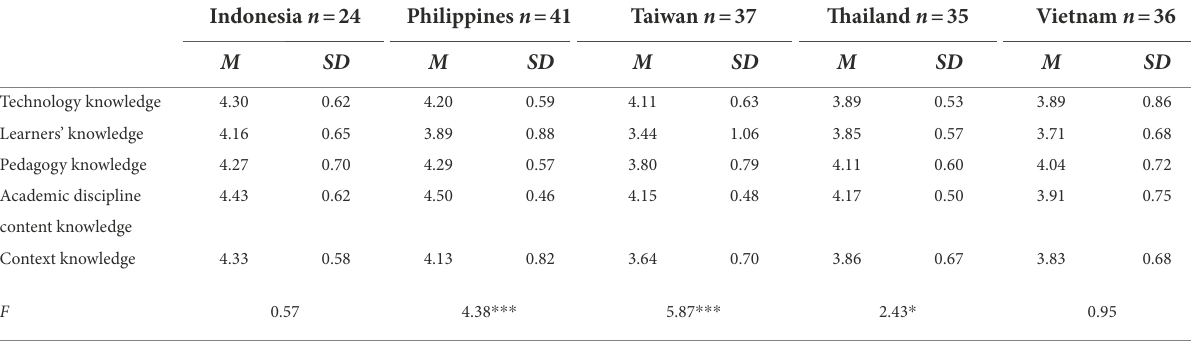
TABLE 3 Mean scores and standard deviations of TLPACK teachers from different countries.